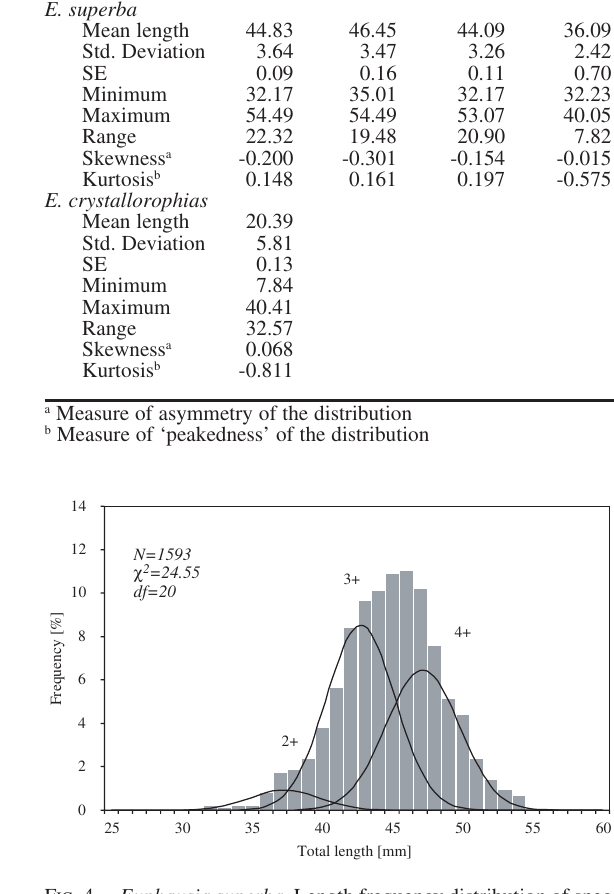
F IG . 4. – Euphausia superba . Length frequency distribution of spec- imens from all the samples and relative fitted components determined by distribution mixture